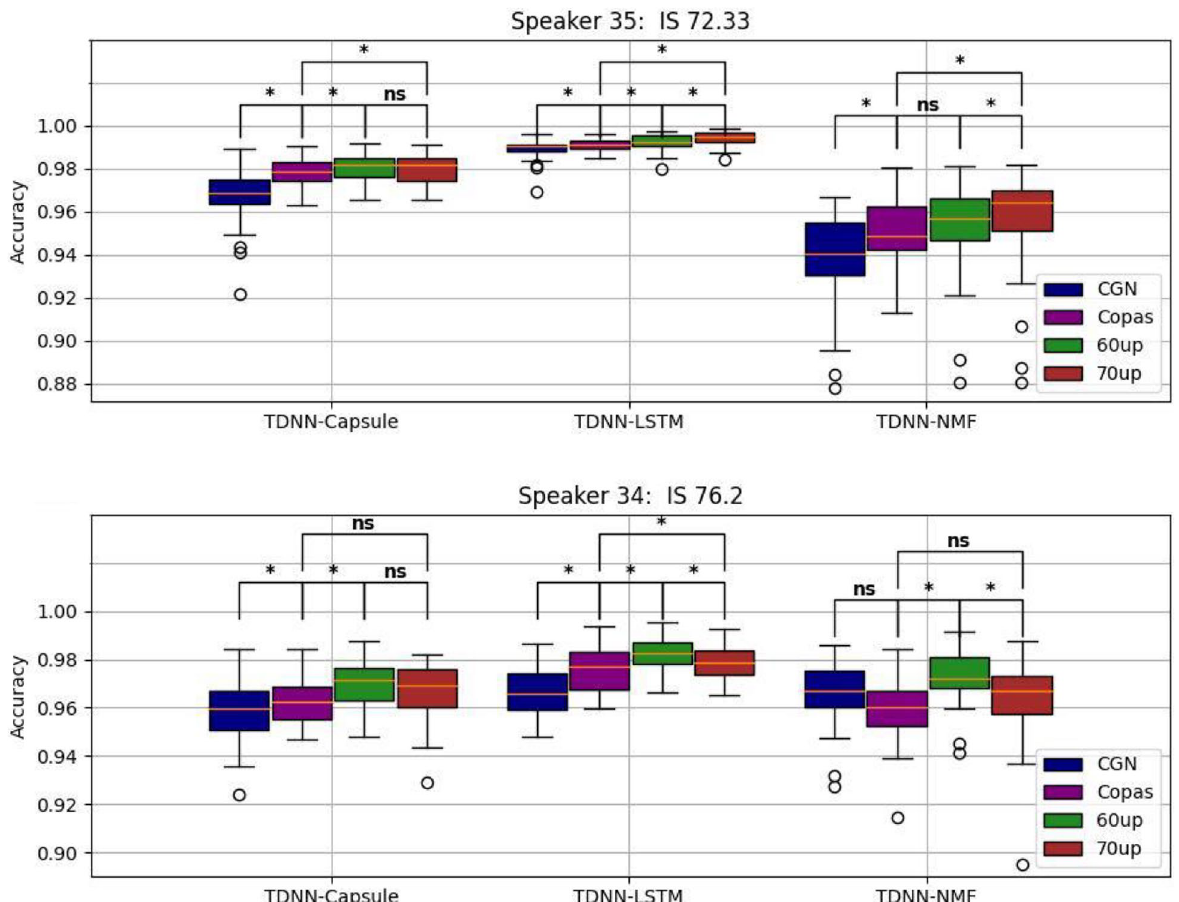
Fig. 13 Performance of the TDNN acoustic models combined with the capsule network, LSTM, and NMF decoder for SLU with insufficient task-specific training data for the speaker 35 and the speaker